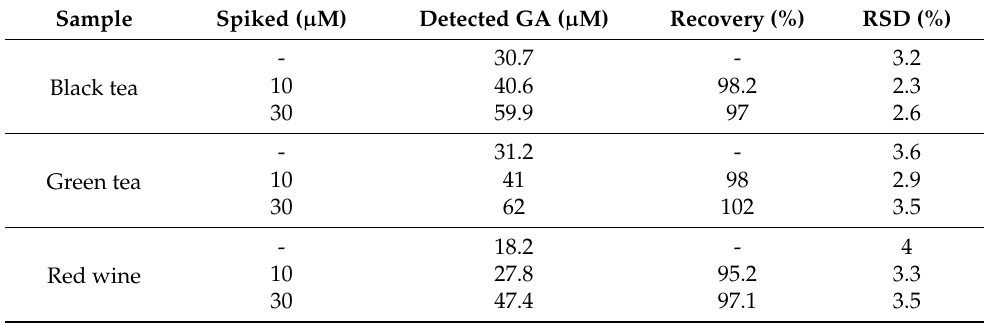
Table 3. Results of the analysis of GA in black/green tea and red wine.